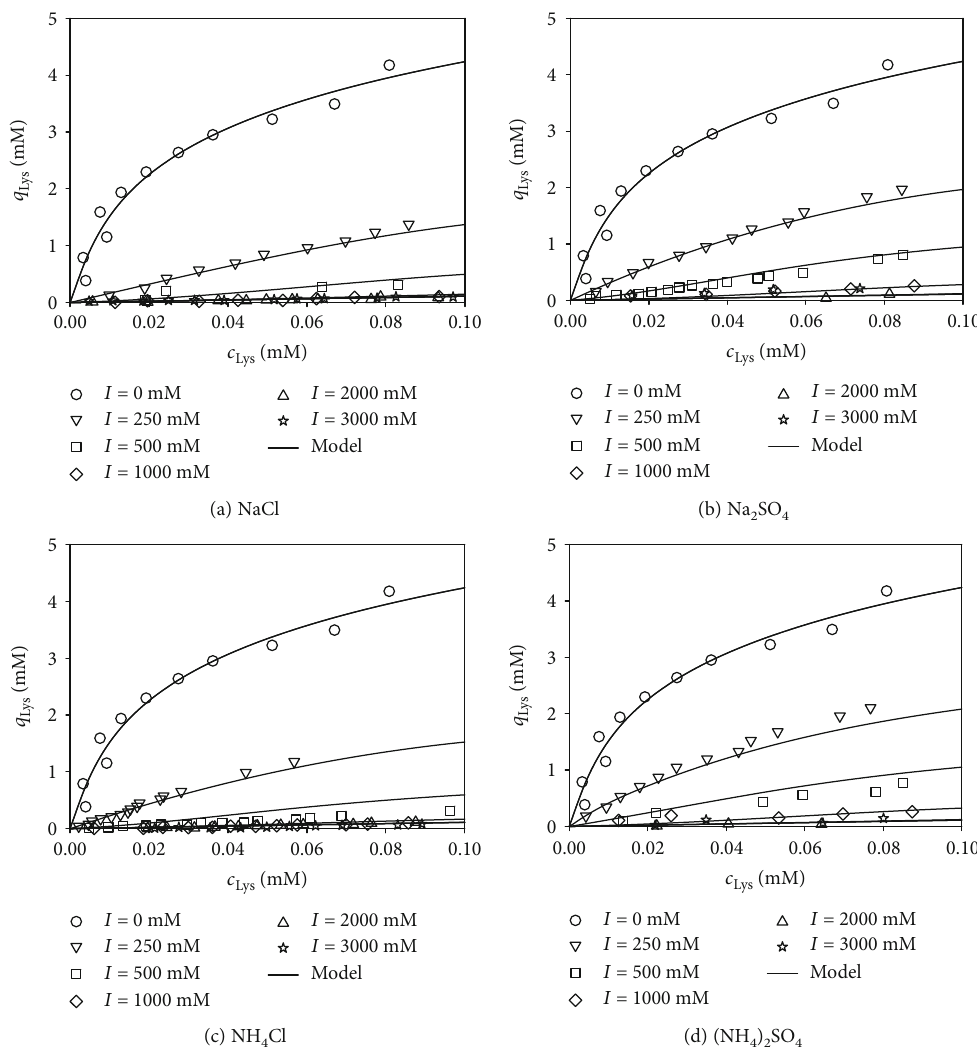
Figure 6: Comparison of modeled equilibrium adsorption isotherms (lines) to experimental data (symbols) for lysozyme on Toyopearl MX-Trp-650M at pH 7.0 and 25 ° C for di ff erent ionic strengths I of (a) sodium chloride, (b) sodium sulfate, (c) ammonium chloride, and (d) ammonium sulfate. Data for I = 1500 mM and I = 2500 mM, which were also measured in the present work, are not depicted here for improved